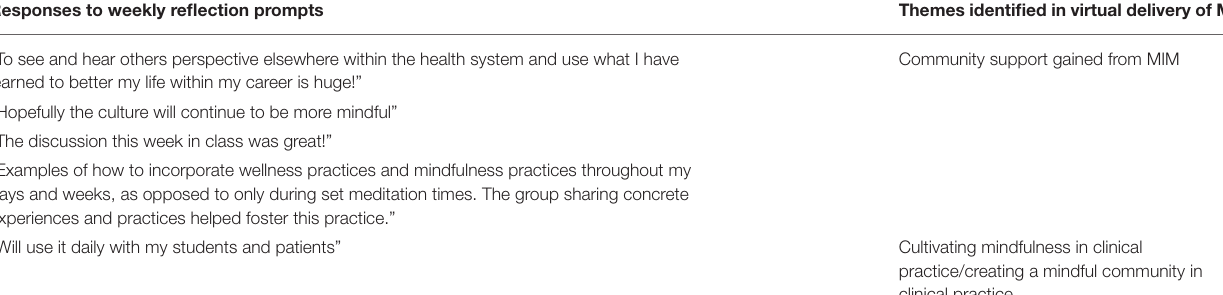
TABLE 2 | Qualitative feedback from COVID